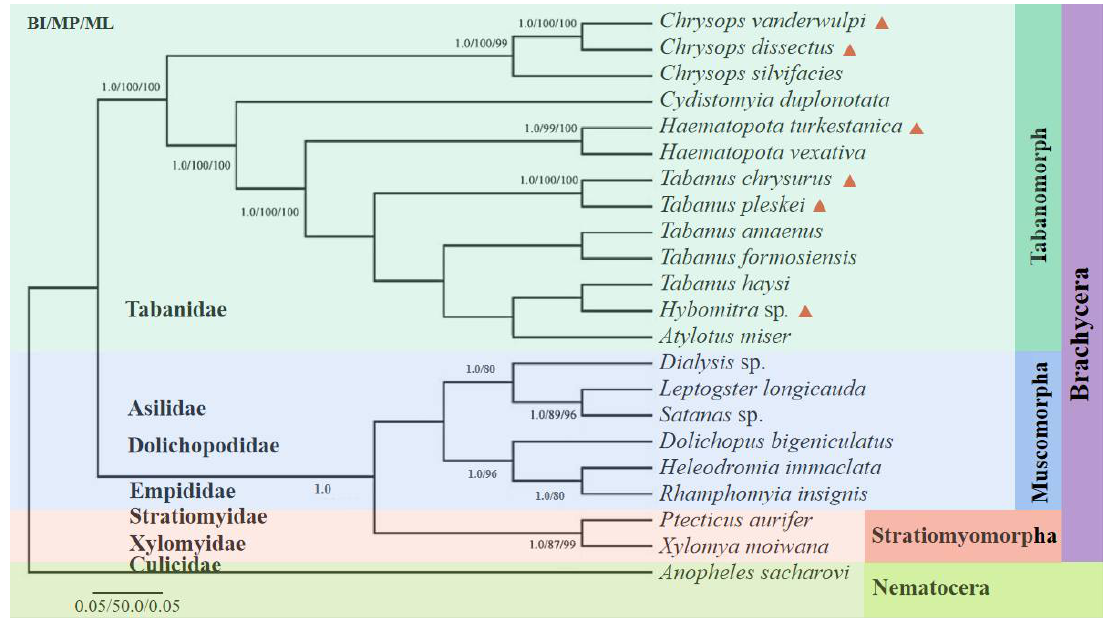
Figure 8. Phylogenetic reconstruction by analyzing the 13 PCGs concatenated amino acid sequences of 22 mitogenomes using Bayesian inference, maximum likelihood and maximum parsimony anal- ysis. The species sequenced in this study were marked with red triangles. Values less than 80 are not displayed.